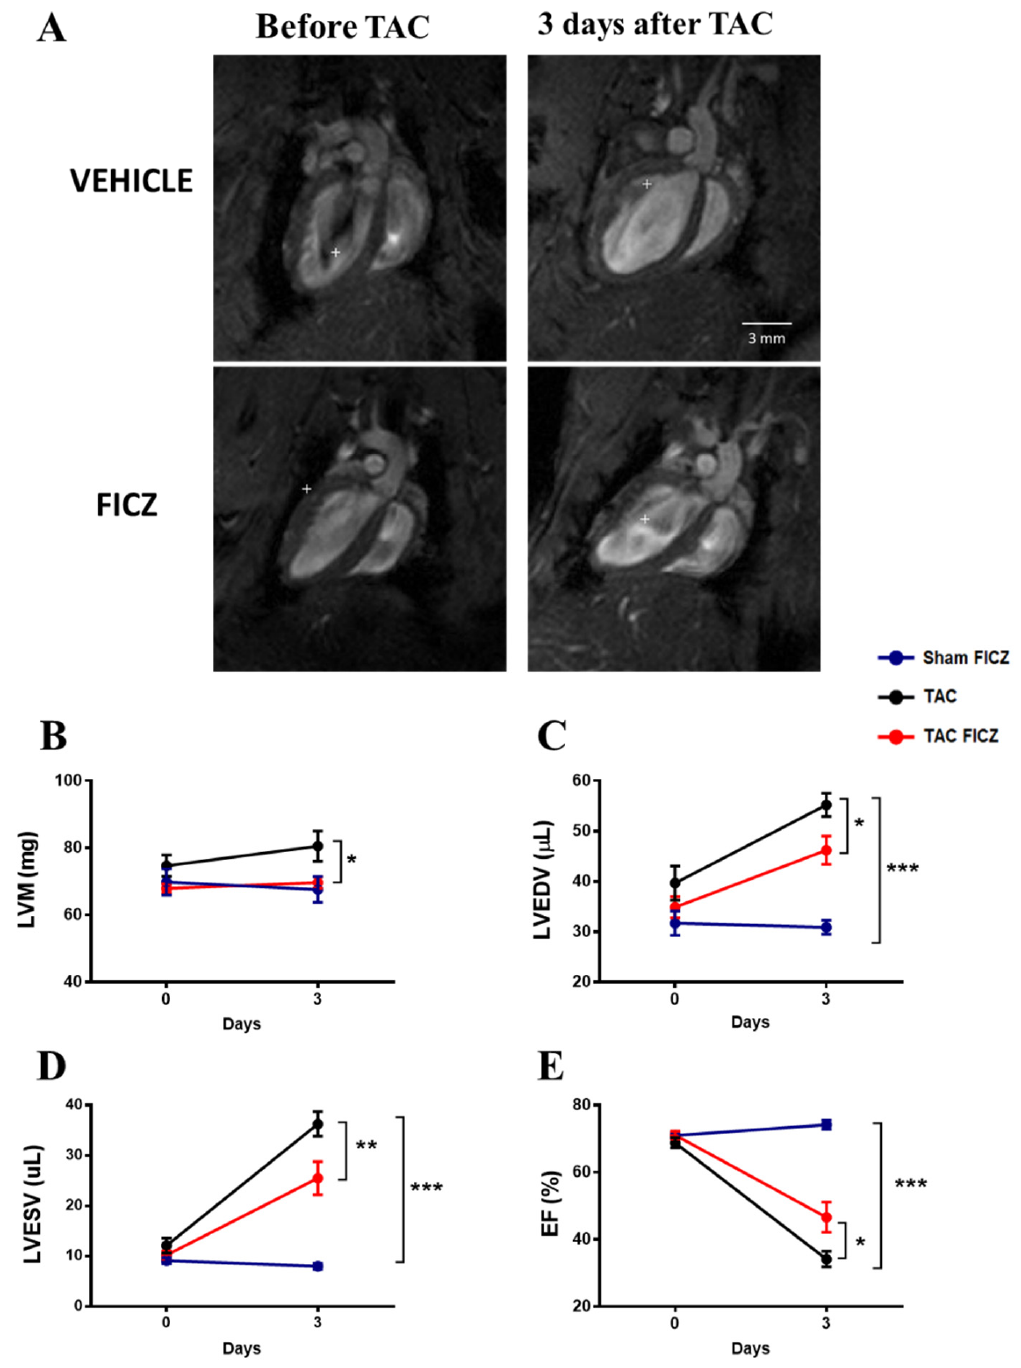
Figure 2. FICZ administration prevents the increase in left ventricular mass (LVM) and improves cardiac dysfunction in mice subjected to TAC surgery: ( A ) Representative cardiac magnetic resonance images (CMRI) of mouse hearts before TAC and 3 days after TAC surgery, and treated with vehicle or with FICZ. CMRI analysis of LVM ( B ), left ventricular end-diastolic volume (LVEDV) ( C ), left ventricular end-systolic volume (LVESV) ( D ), and ejection fraction (EF) ( E ). Groups are: Sham FICZ (blue circles) ( N = 8), TAC (black circles) ( N = 8) and TAC FICZ (red circles) ( N = 8). Data are expressed as mean ± SEM. * p < 0.05; ** p < 0.01; *** p < 0.001.